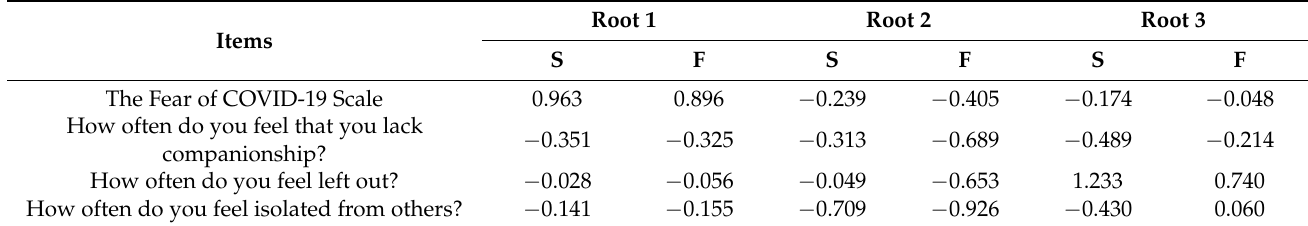
Table 2. Standardized discriminant coefficients and correlations with discriminant functions.